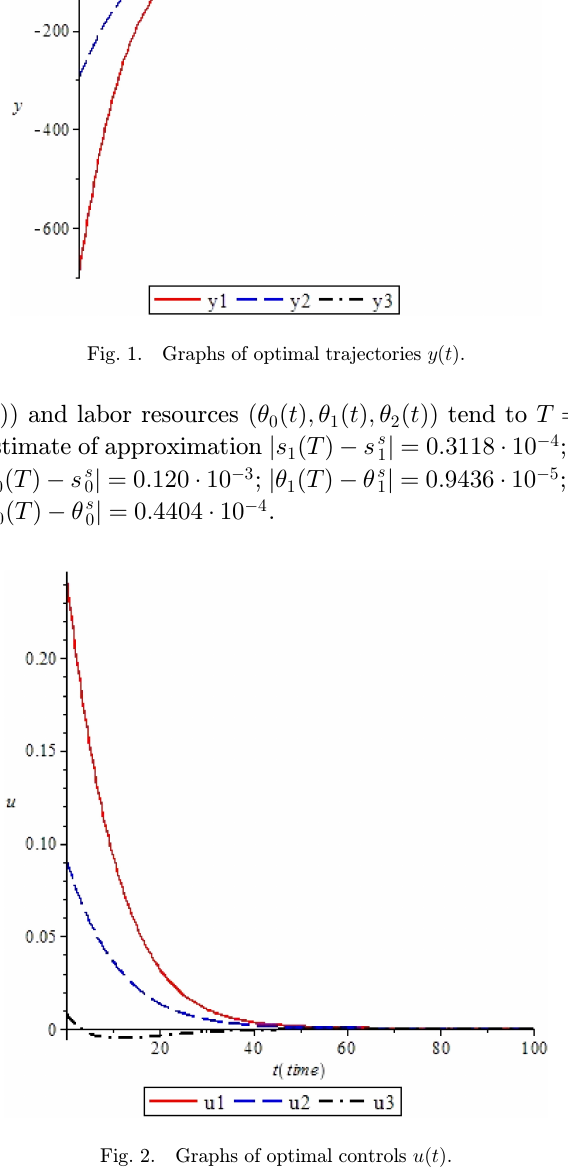
Fig. 2. Graphs of optimal controls u ð t Þ